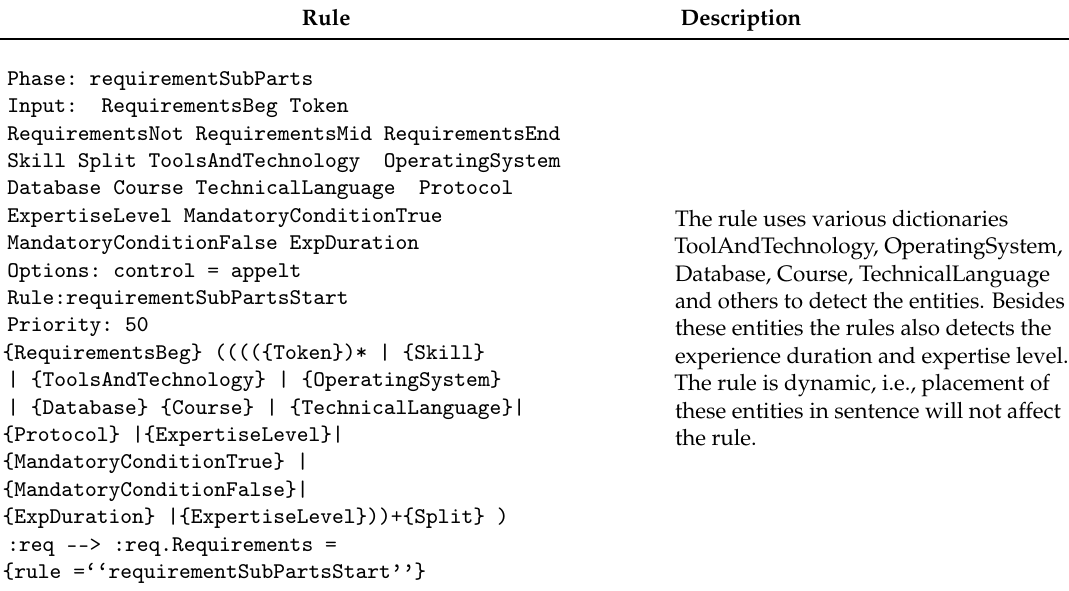
Table 6. Sample rule for job extraction of requirement using JAPE in